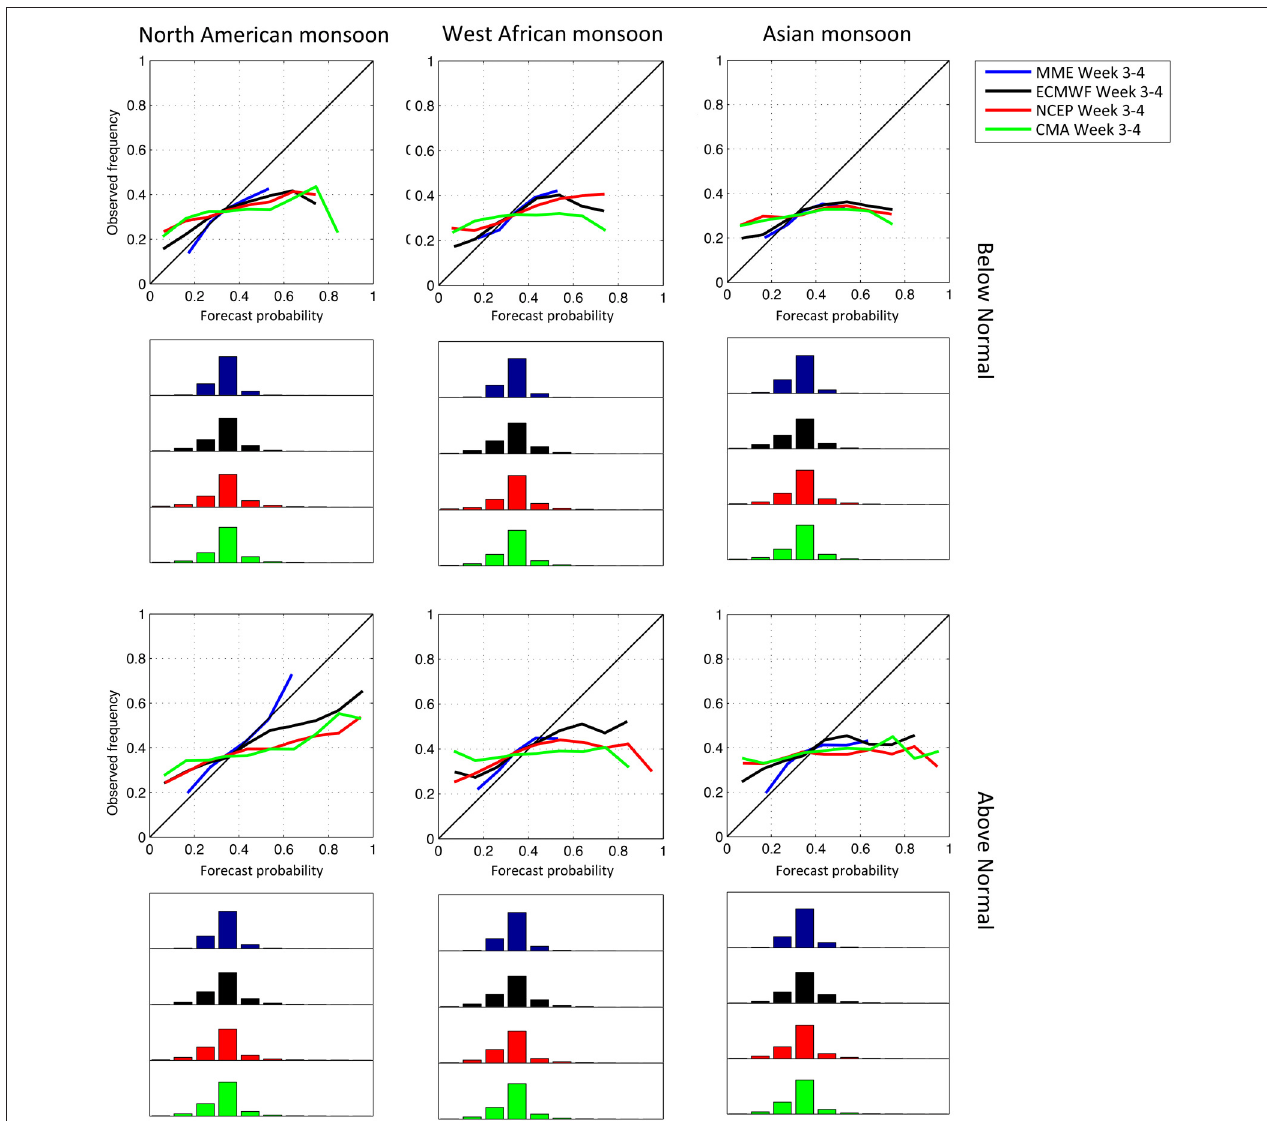
FIGURE 8 | Week 3–4 reliability diagrams for the below- (top) and above-normal (bottom) categories from ECWMF (black), NCEP (red), and CMA (green) forecasts with starts in May–Aug together with their MME (blue) computed for landpoints of the North American (left), West African (center) and Asian (right) summer monsoon regions. The frequencies with which each category is forecasted are indicated as bins centered on integer multiple of 0.10 in histograms plotted under the respective tercile category diagram for each forecast in their respective colors. The bins are projected along the same x-axis (forecast probabilities from 0 to 1) and scaled from 0 to 100%. Note that only bins with more than 1% of the total number of forecasts in each category are plotted.